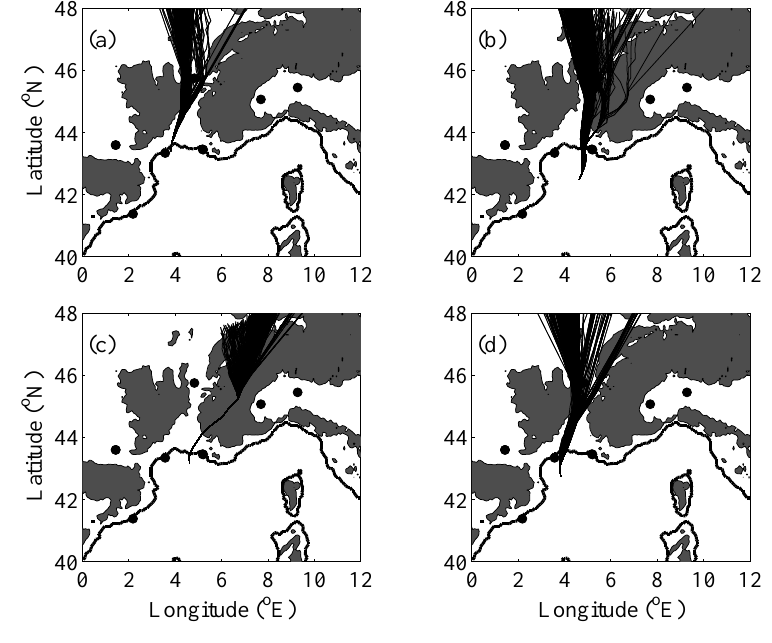
Fig. 14. Same as Fig. 13 but for back plumes ending at 2000m m.s.l.